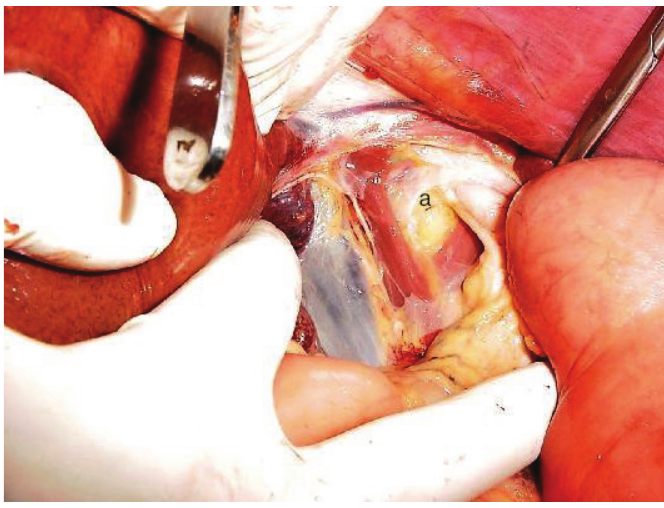
FIgURE 2 - complete exposure of the esophageal hiatus ( a ) during dissection type 1.